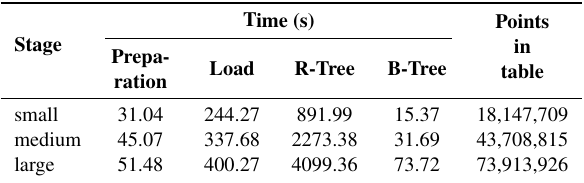
Table 7: The incremental loading times of the validation. Preparation refers to the reading of the LAZ files and their transformation to suitable representations for loading.